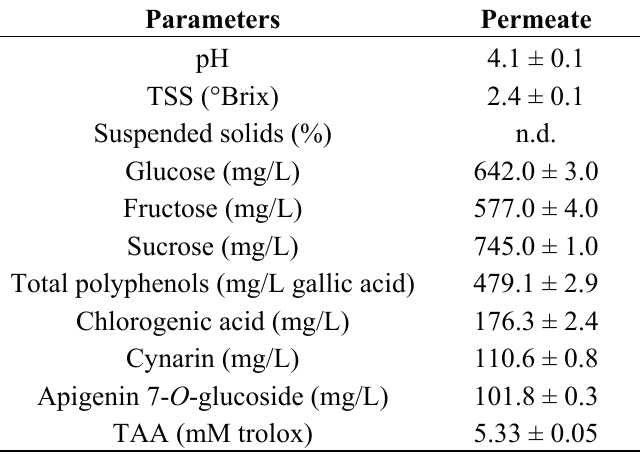
Table 1. Physicochemical composition of the clarified artichoke